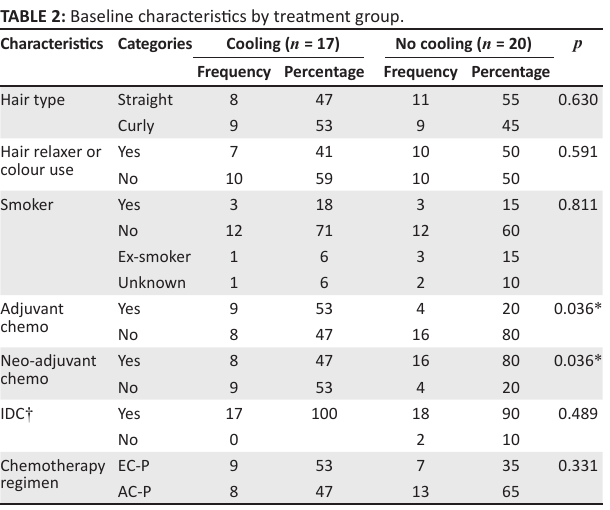
TABLE 2: Baseline characteristics by treatment group. Characteristics Categories